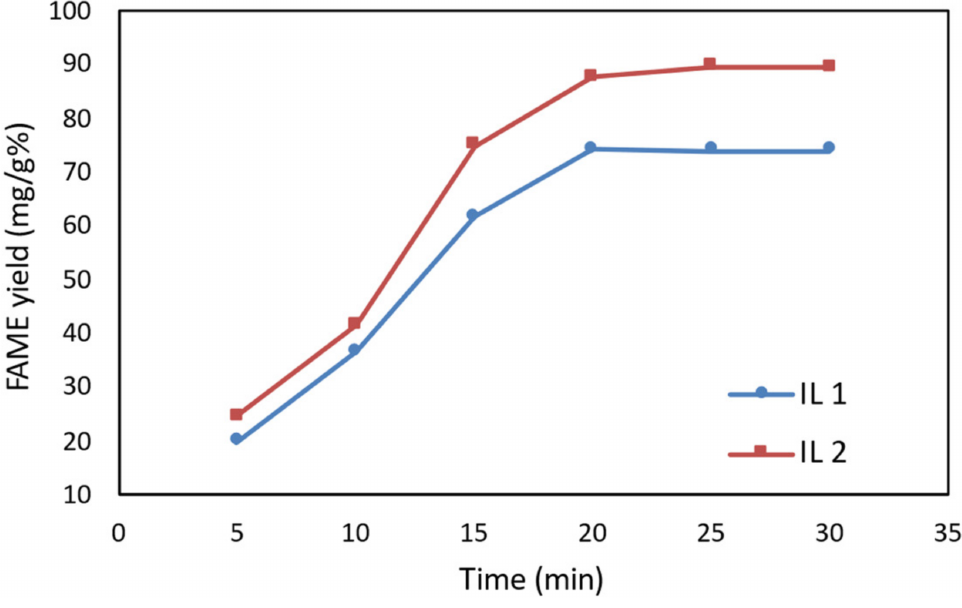
Figure 3. Effect of reaction time on FAME